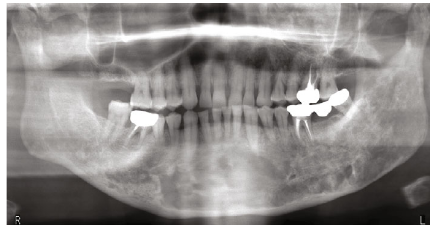
Figure 1: A panoramic radiograph obtained during the initial visit.